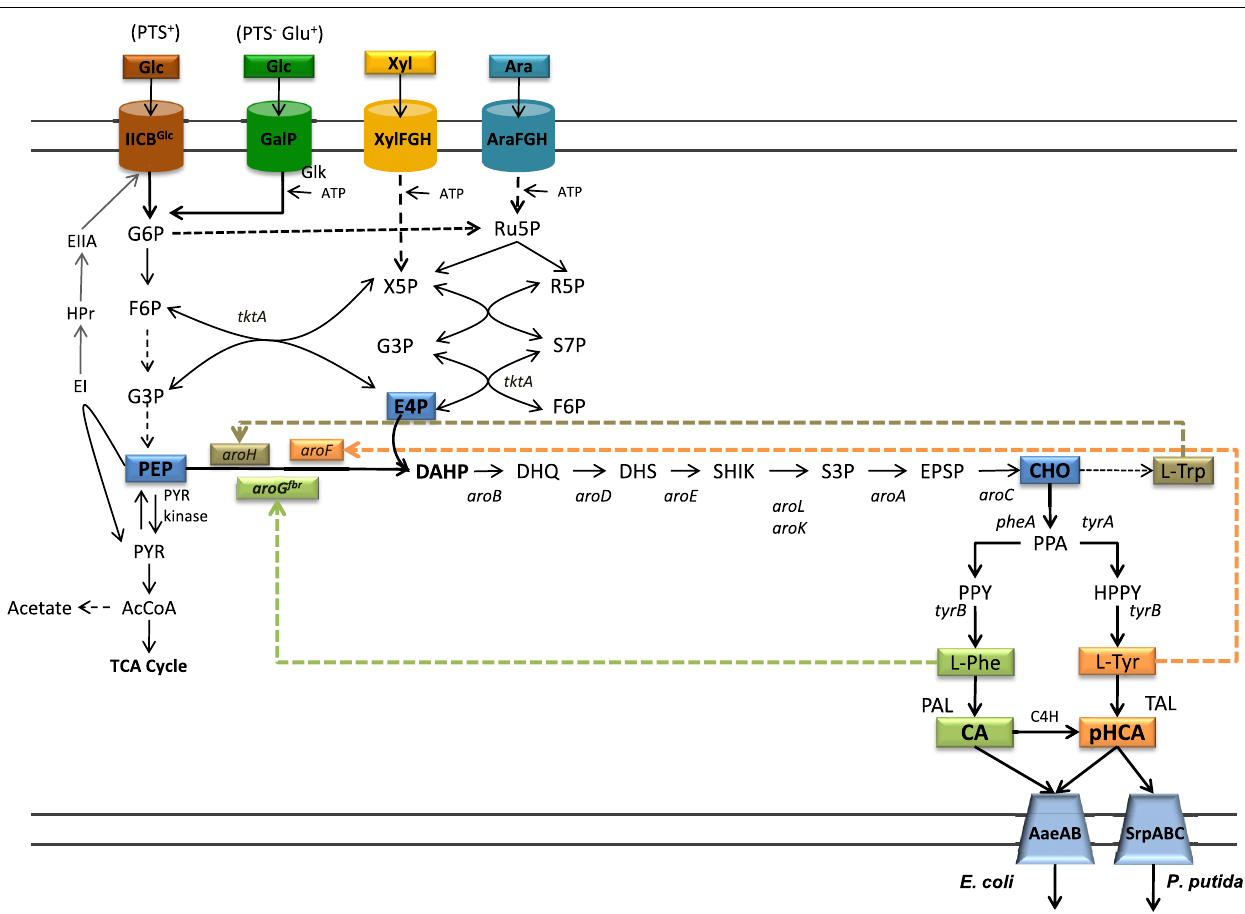
FIGURE 1 | Central metabolism, aromatics biosynthetic pathways, and transport pathways from engineered E. coli . Dashed arrows indicate multiple enzyme reactions. EI, PTS enzyme I; HPr, PTS phosphohistidine carrier protein; EIIA, PTS glucose-specific enzyme II; PTS IICB Glc , integral membrane glucose permease; GalP, galactose permease; XylFGH, xylose transport proteins, AraFGH, arabinose transport proteins; DAHPS, DAHP synthase; aroG fbr , gene encoding a feedback-inhibition-resistant version of DAHPS; tktA ,